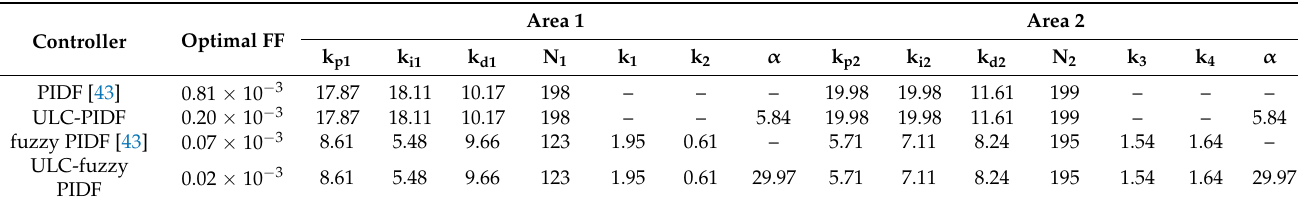
Figure 9. Convergence curves of the MPA algorithm for ( a ) ULC-PIDF and ( b ) ULC-fuzzy PIDF controllers. Table 3. optimal performance and gains of various controllers in terms of fitness.